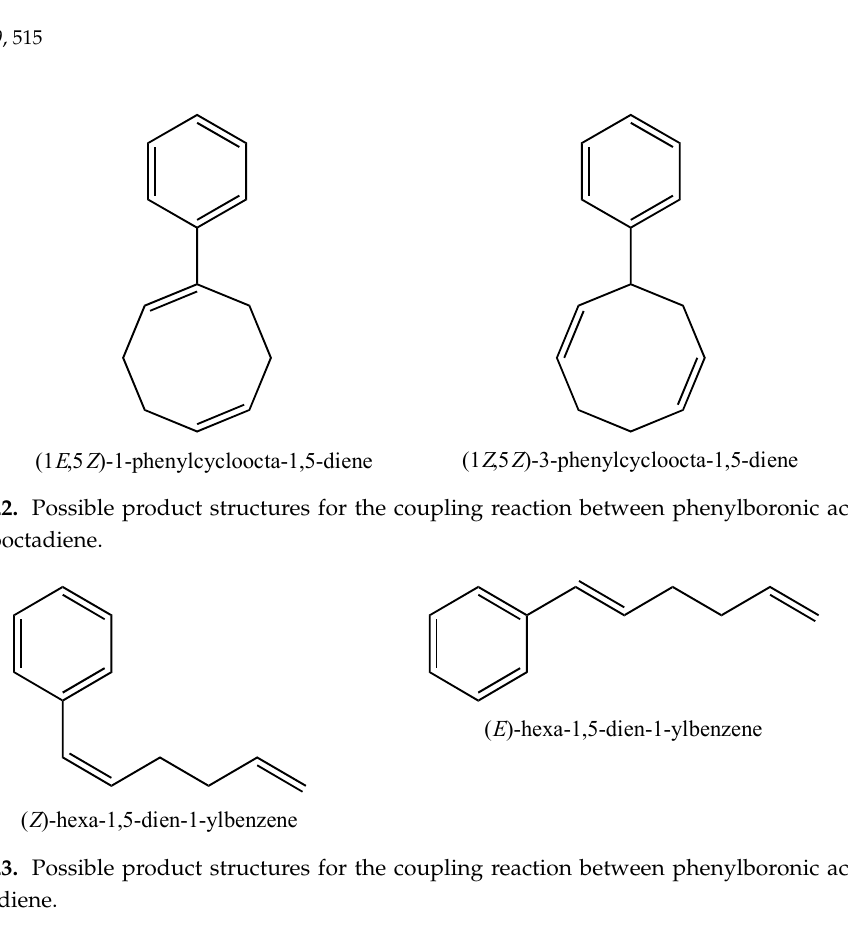
Figure 23. Possible product structures for the coupling reaction between phenylboronic acid and 1,5- hexadiene.